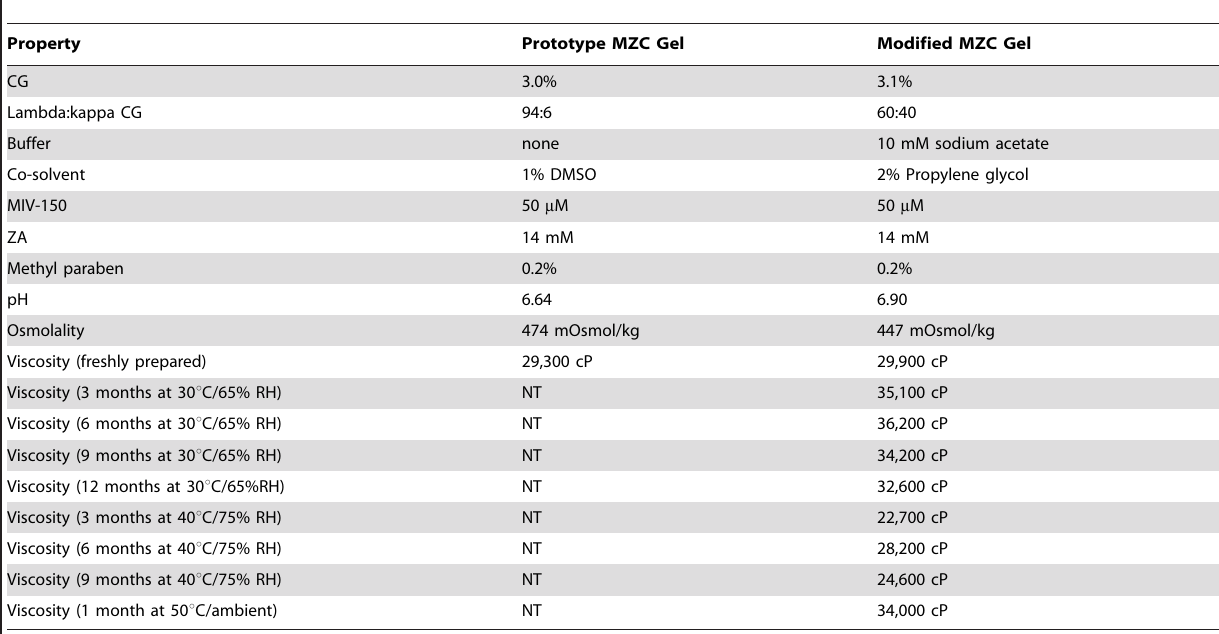
Table 1. Formulation attributes after long term stability testing.